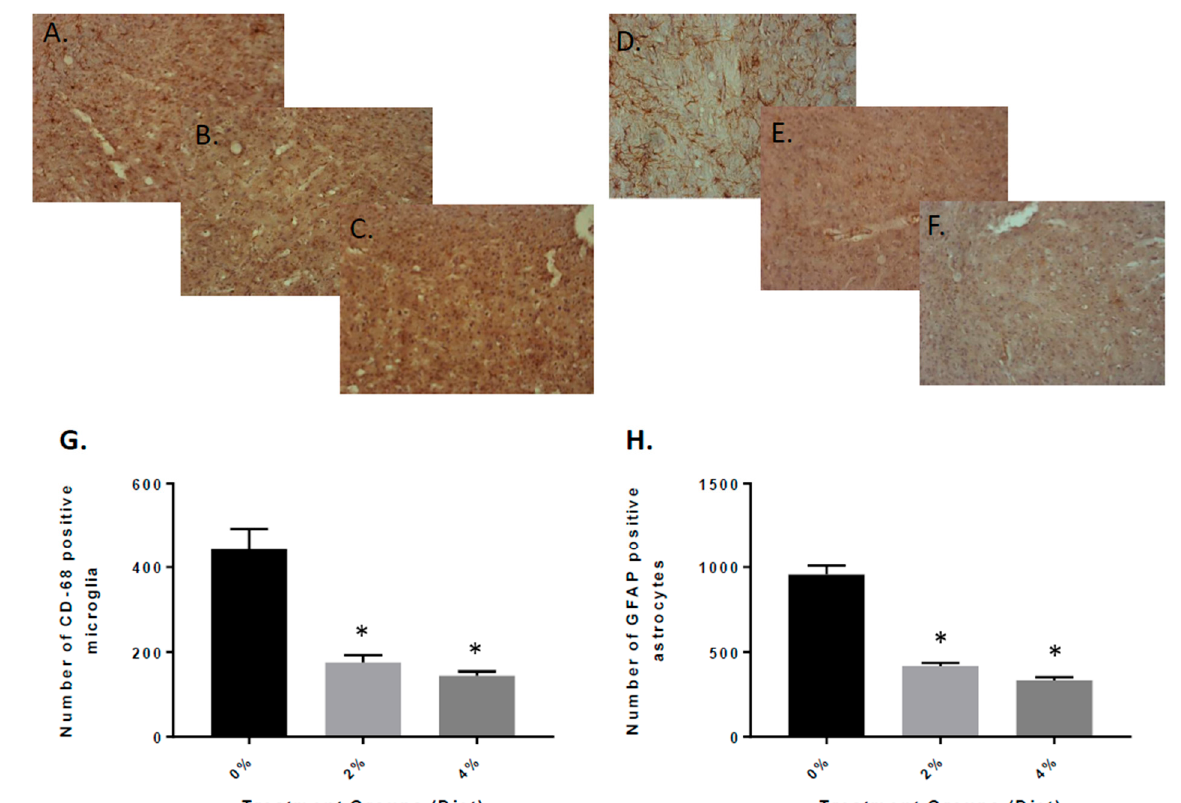
Figure 4. Quantitative analysis of activated microglia and astrocytes in the brain of APP/PS1 mice after 4 months of GF diet treatment. Brain sections from APP/PS1 control mice ( A ) or mice treated with GF diet at 2% ( B ) or 4% ( C ) were stained with anti-mouse CD68 antibody to detect the activated microglial cells. Ten sections of each mouse were counted and averaged for the number of CD68-activated microglia in the brain (* p < 0.001, n = 20). Brain sections from APP/PS1 control mice ( D ) or mice treated with GF diet 2% ( E ) or 4% ( F ) were immunostained with anti-mouse GFAP antibody to detect the activated astrocytes. Ten sections of each mouse were counted and averaged for the number of GFAP-activated astrocytes in the brain (* p < 0.001; n = 20). ( G , H ) : quantification of data from the section for CD-68 and GFAP, respectively.